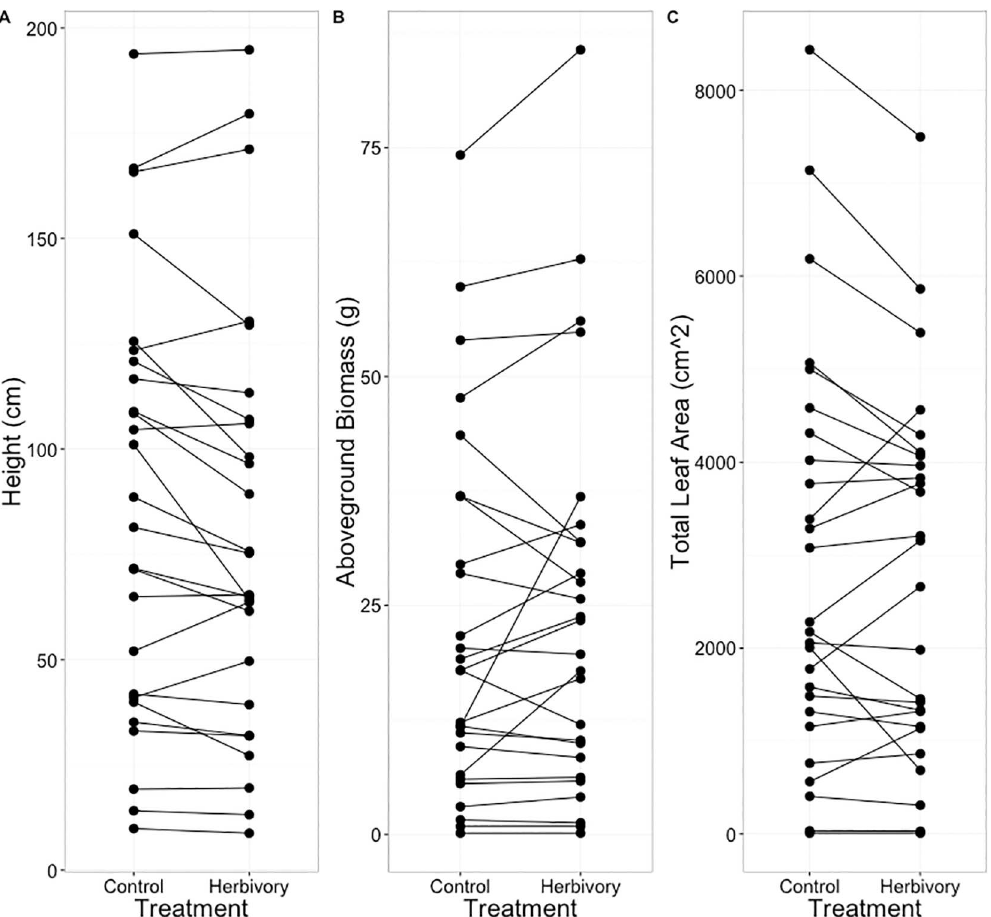
Fig 1. Whole plant performance responses to simulated defoliation. Average (A) height, (B) aboveground biomass, and (C) total leaf area for each speciestreatment group. Positive, negative,and non-significant differences betweenherbivoryand control groups were observed for each performance variable,but there were no significanteffects of